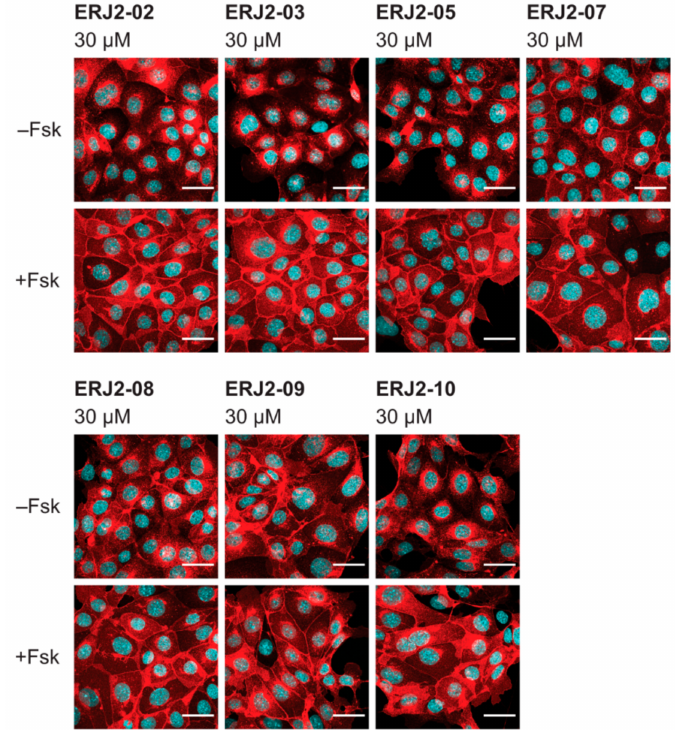
Figure A1. Supplement to Figure 3. Effects of Aurora-A inhibitor I derivatives on the localization of AQP2 in MCD4 cells. MCD4 cells were left untreated or treated with DMSO (0.3%, 1 h) or compound (30 µ M, 1 h) alone or in combination with forskolin (Fsk; 30 µ M, 30 min) where indicated. AQP2 was detected by immunofluorescence microscopy as described in the legend of Figure 1. Shown are representative images of four independent experiments; scale bar 30 µ